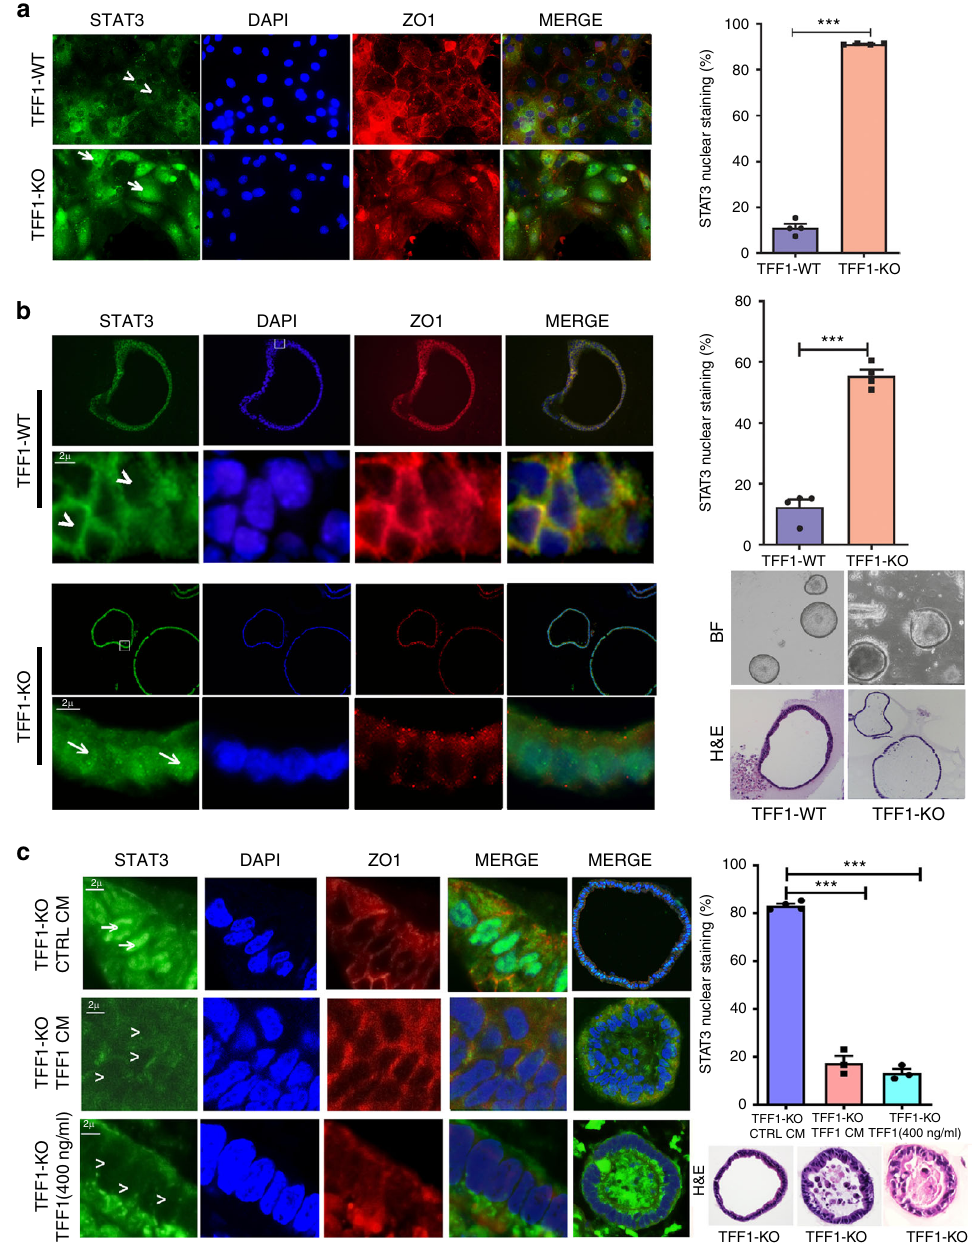
Fig. 3 TFF1 suppresses STAT3 nuclear localization in ex vivo and 3D organoid cultures. a Ex vivo immuno fl uorescence staining of p-STAT3 (Y 705) in gastric epithelial cells isolated from the antropyloric region in TFF1-wild type (TFF1-WT) or TFF1-knockout (TFF1-KO) mice. As shown, there was absence of nuclear p-STAT3 staining in TFF1-WT cells (arrowheads in upper panels), whereas strong nuclear p-STAT3 was detected in TFF1-KO (arrows in lower panels). Quanti fi cation of nuclear p-STAT3 positive staining in at least 200 counted cells from three different fi elds is presented as percentage ± SEM (right panel); *** P < 0.001 by two-tailed Student ’ s t test. b 3D organoid cultures derived from antropyloric glands of TFF1-WT (upper two panels) and TFF1-KO (lower two panels) showing nuclear localization of p-STAT3 in TFF1-KO organoids (arrows), but not in TFF1-WT (arrowheads). c Immuno fl uorescence assay performed on organoids derived from the antrum of TFF1-KO mouse stomach. Cells showing nuclear staining of p-STAT3 in organoids treated with conditioned media from AGS-pcDNA cell line (Ctrl CM) for 24 h (upper panel). Organoids treated with TFF1 conditioned media from AGS-TFF1 cell line (TFF1 CM) displayed loss of nuclear staining (arrowheads) of p-STAT3 (middle panel). Organoids treated with recombinant TFF1 protein (400 ng mL − 1 ) showed absence of p-STAT3 (arrowheads) nuclear staining (lower panels). The merge of the representative full organoid gland and its H&E staining is presented in the right panels. Scale bar 2 µ m. Original magni fi cation is ×600. Zo1 (red) was used as an epithelial cell marker, and DAPI (blue), as a nuclear counterstain. Graph showing the quanti fi cation of nuclear p-STAT3-positive cells in at least 4 counted organoid glands (at least 25 – 50 cells in each organoid) presented as percentage± SEM (right upper panel); *** P < 0.001 by two-tailed Student ’ s t test. H&E staining and bright fi eld images (BF) of representative organoids are shown on the right of panels ( b ) and ( c